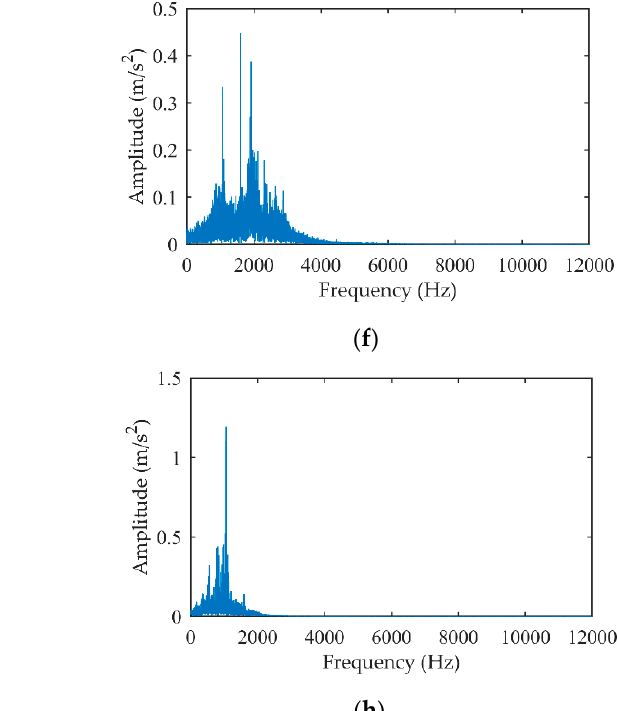
Table 3. The kurtosis of the first four IMFs (the single ‐ stage gearbox experiment). Intrinsic Mode Function (IMF)